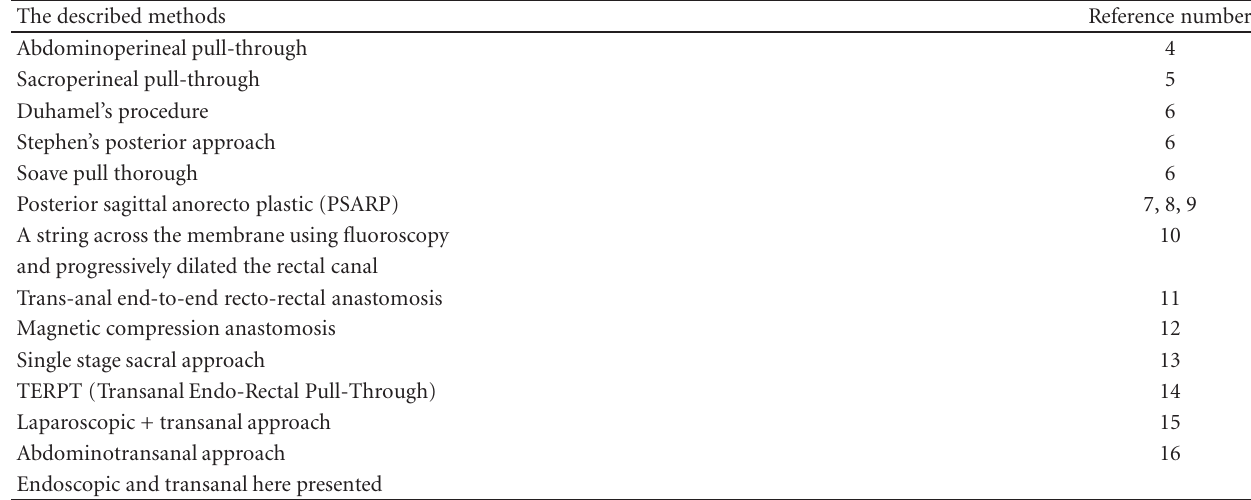
Table 1: Several di ff erent techniques used for operating rectal atresia described in the